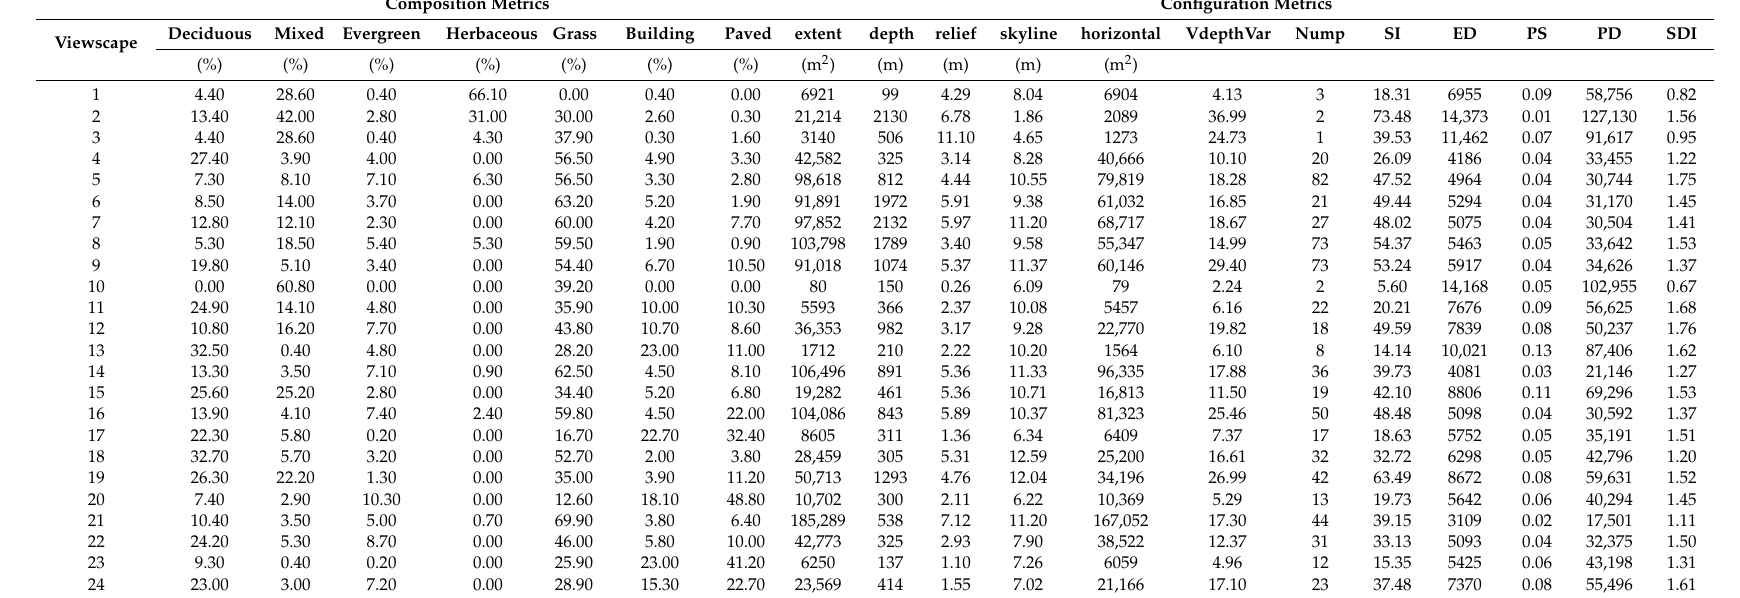
Table 1. Computed viewscape metrics for the 24 IVE scenes used in the